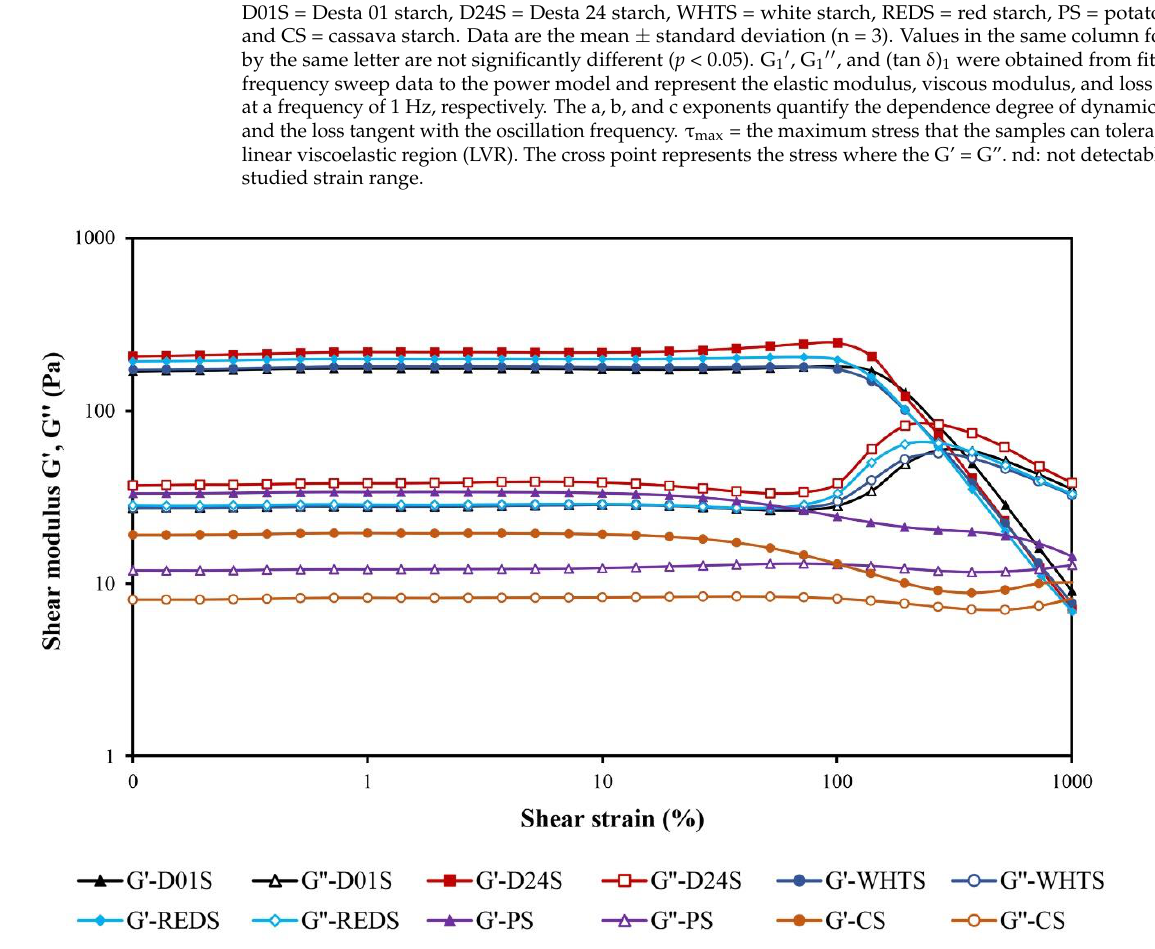
starch, and CS = cassava starch. Data are the mean ± standard deviation (n = 3). Values in the same column followed by the same letter are not significantly different ( p < 0.05). G 1 ′, G 1 ′′ , and (tan δ) 1 were obtained from fitting the frequency sweep data to the power model and represent the elastic modulus, viscous modulus, and loss tangent at a frequency of 1 Hz, respectively. The a, b, and c exponents quantify the dependence degree of dynamic moduli and the loss tangent with the oscil- lation frequency. τ max = the maximum stress that the samples can tolerate in the linear viscoelastic region (LVR). The cross poi nt represents the stress where the G’ = G’’. nd: not detectable in the studied strain range. The starches from the four anchote cultivars showed significant variations in their maximum stress (τ max ) resisted by the gels before the disruption of their structure, which